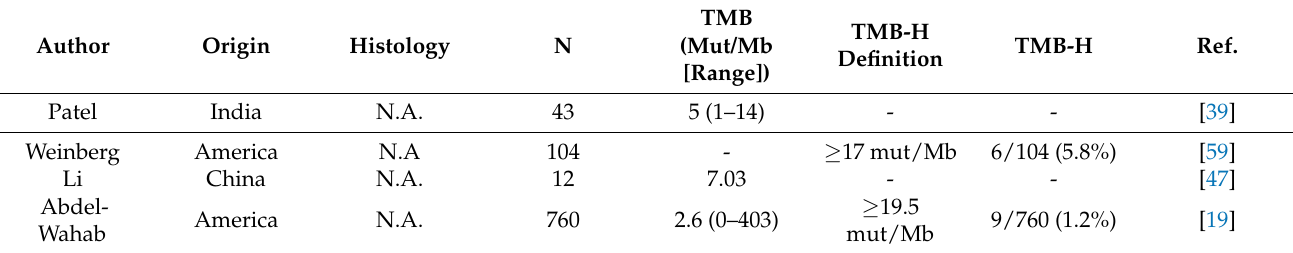
Table 2. Tumor mutational burden in gallbladder